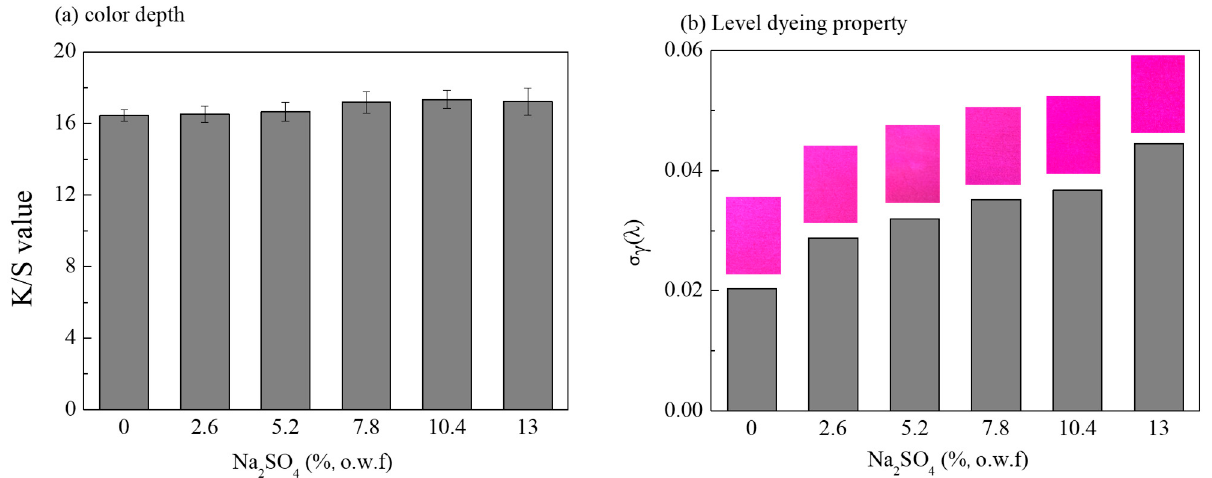
Figure 3. K/S value ( a ) and level dyeing property ( b ) of dyed fabrics under different Na 2 SO 4 concentrations in siloxane non-aqueous dyeing system.